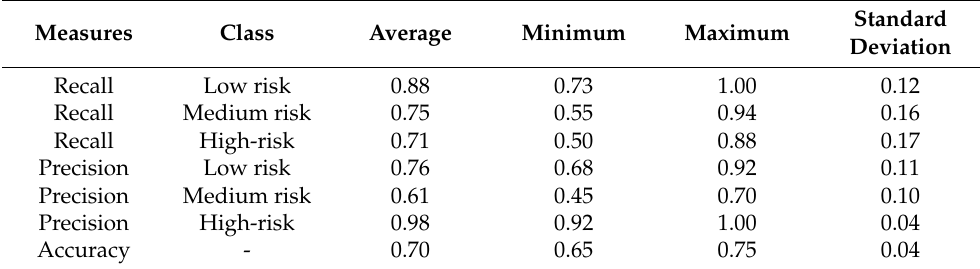
Table 5. Average, minimum, and maximum value of recall, precision, and accuracy.